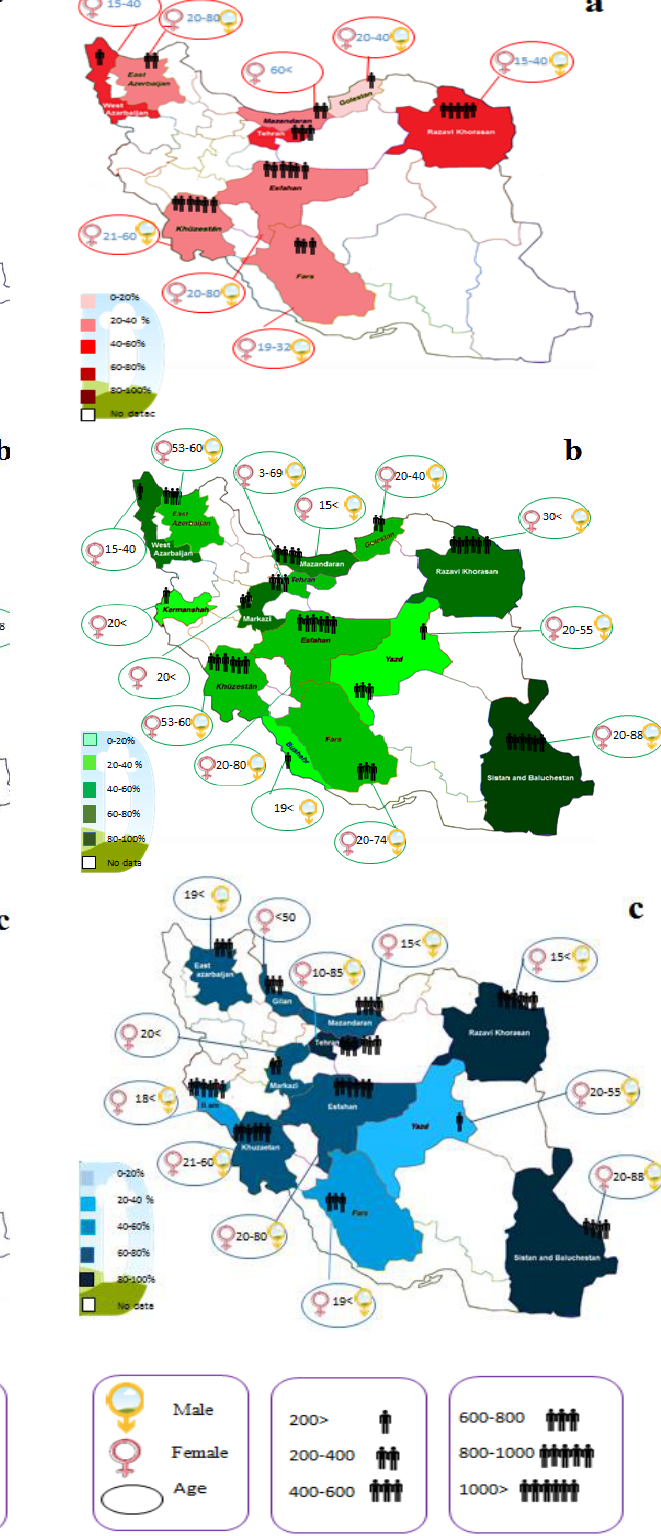
Figure 4 . The prevalence of vitamin D deficiency in Iranian children and adolescents using cut-off values of 12 and 20 ng/ml, as well as prevalence of 25-(OH)-D levels <30 ng/ml (a, b, c, respectively)